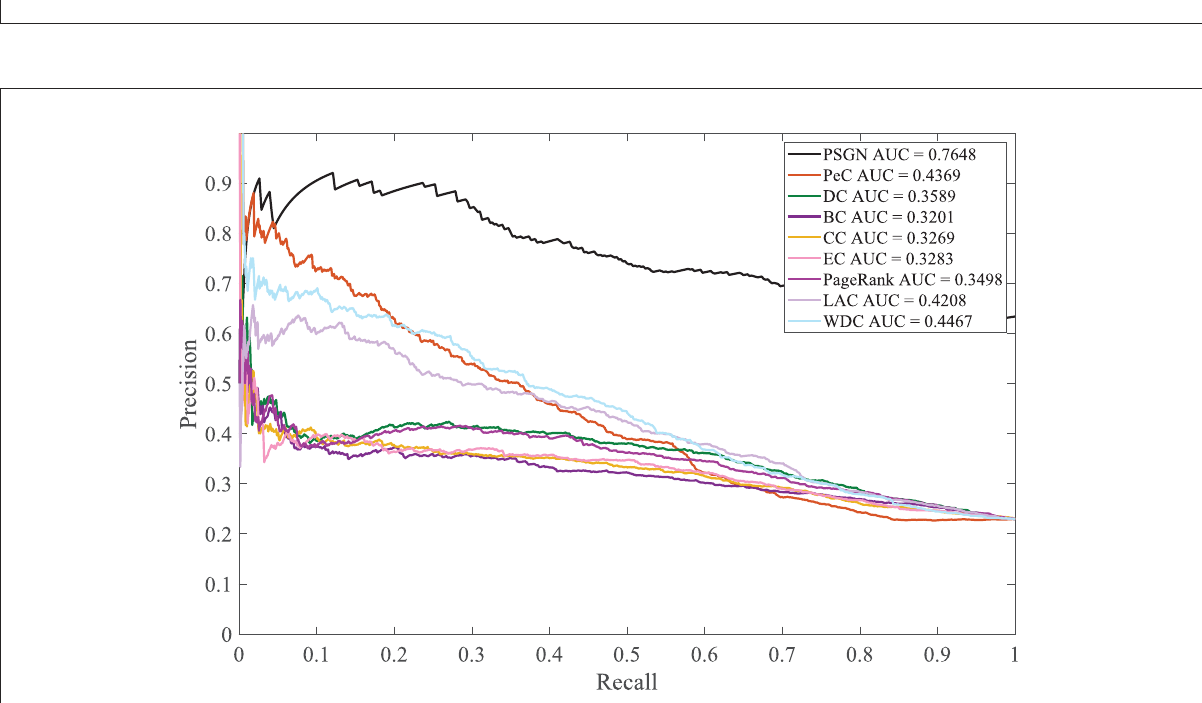
FIGURE5 Comparison of PSGN, BC, CC, DC, EC, LAC, PageRank, PeC, and WDC using precision-recall (PR) curve method.